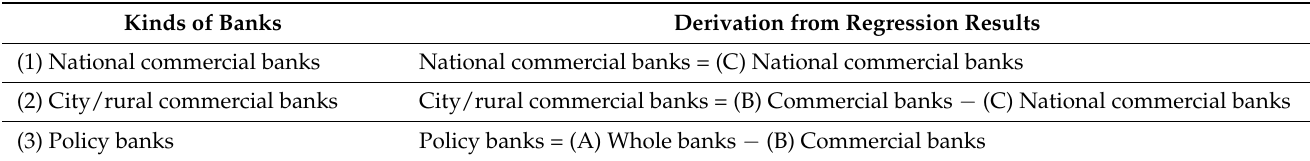
Table 13. Types of